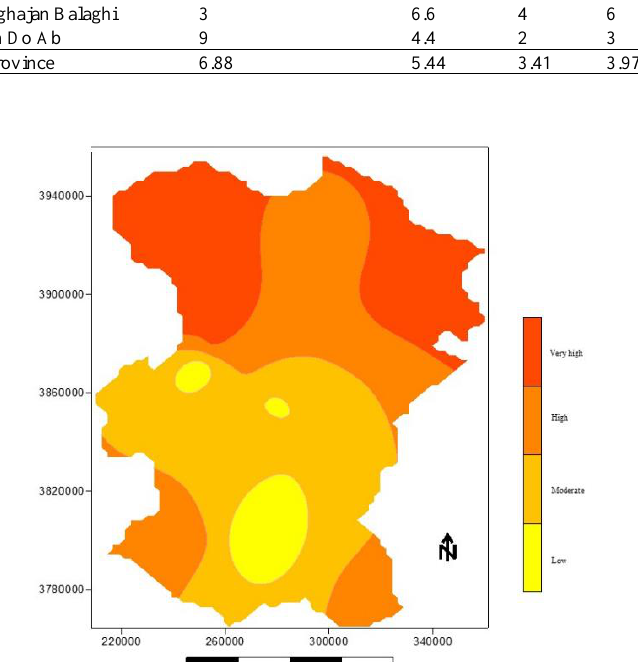
Fig. 8. Classification of flood intensity in Hamedan